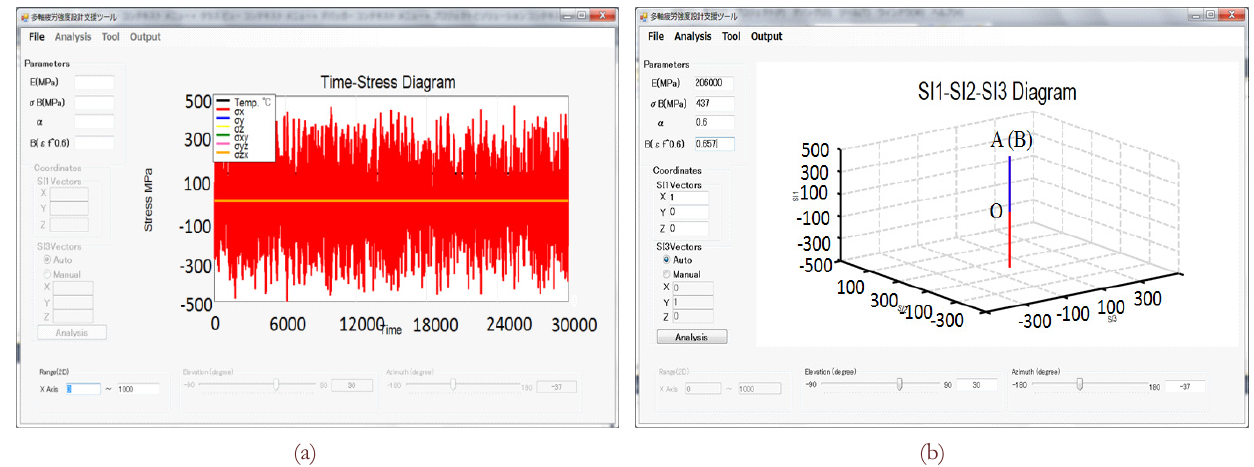
Figure 8: Input and output data under random loading: (a) Input data, (b) Output data in polar coordinates.